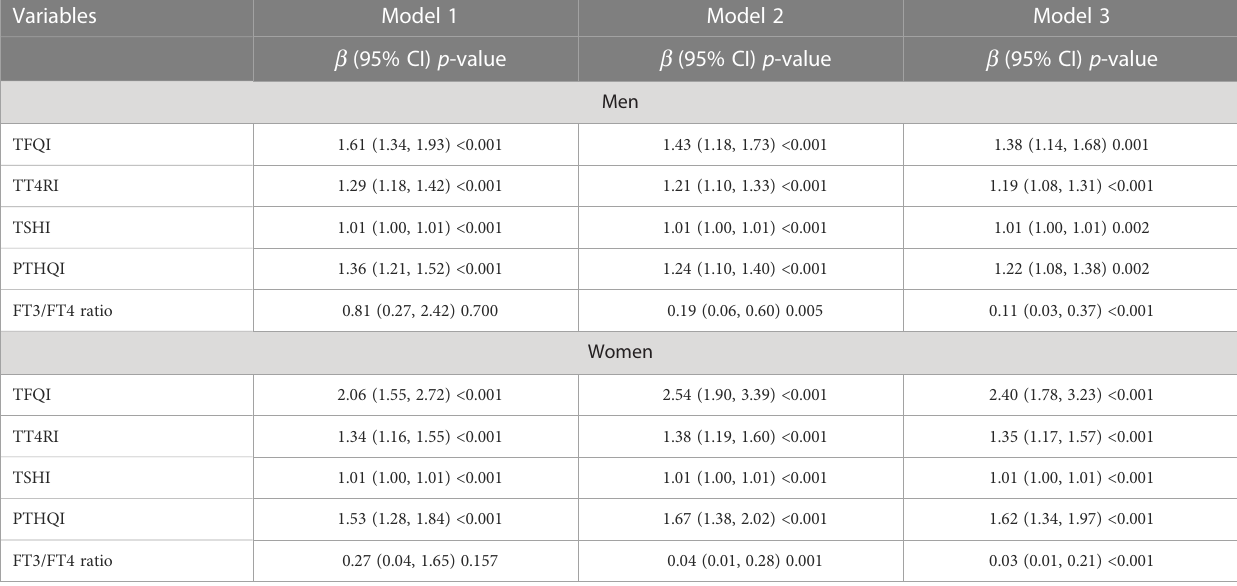
Model 1: Crude model. Model 2: Adjusted for age and BMI. Model 3: Adjusted for age, BMI, diabetes, dyslipidemia, fatty liver, and